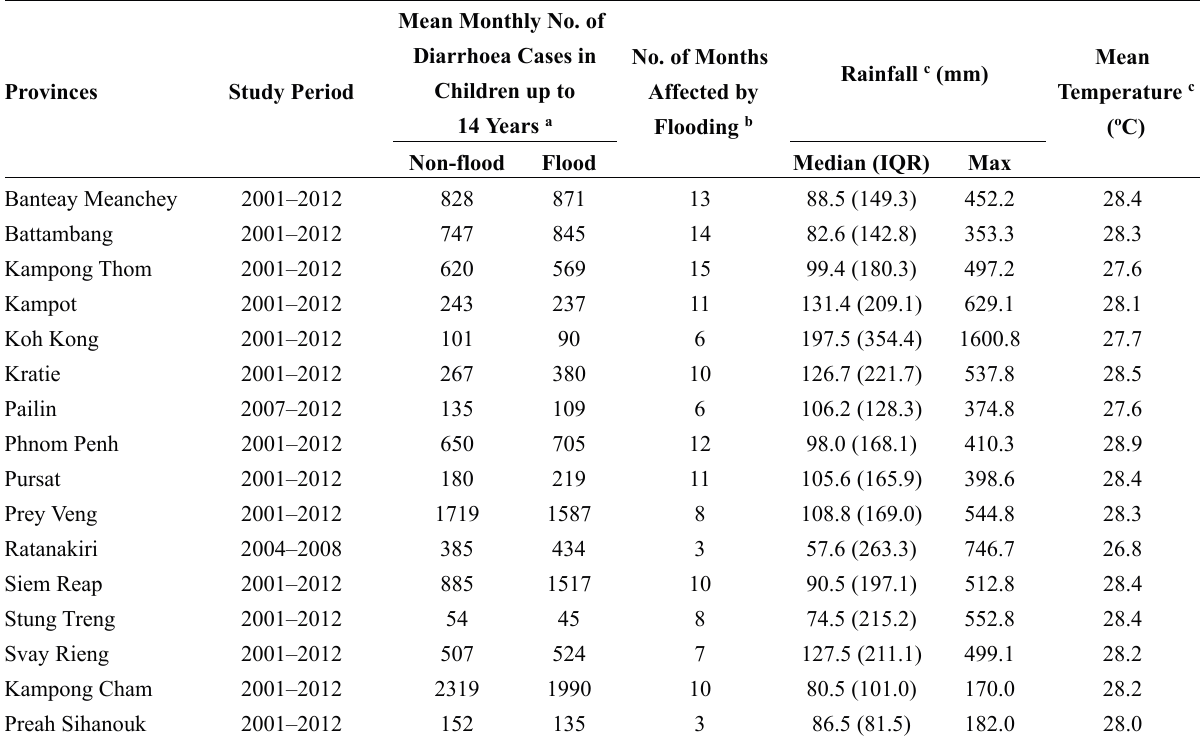
Table 2. Characteristics of the studied provinces in Cambodia. IQR indicates interquartile